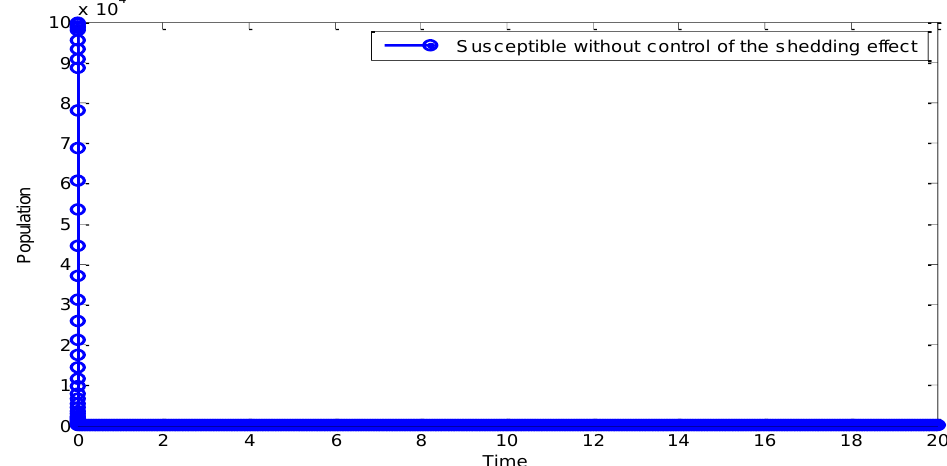
Figure 1. Dynamics of the model.